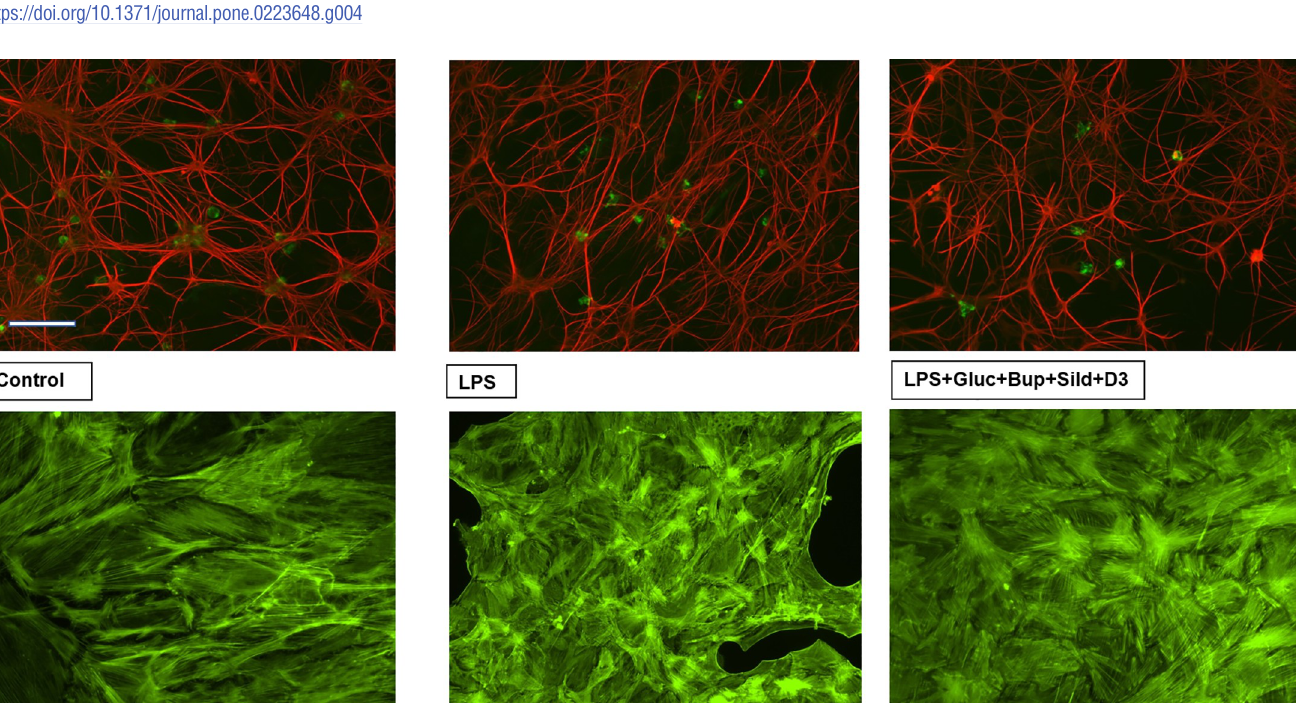
Fig 4. The expression levels of TLR4, NK-1 and Na + /K + -ATPase were studied using western blot analysis. Astrocytes were cultivated in 5.5 mM glucose for the entire cultivation period. The cells were incubated with LPS (10 ng/ml) for 24 h or incubated with LPS for 24 h followed by LPS, 25 mM glucose + bupivacaine (Bup) (10 − 12 M), 25 mM glucose + sildenafil (Sild) (1 μ M) + vitamin D3 (D3) (100 nM), or a combination of all substances for an additional 24 h. The level of significance was calculated against LPS and analyzed using one-way ANOVA followed by Dunnett’s multiple comparisons test. � P < 0.05, �� P < 0.01. n = 6. Representative images of western blot membranes are presented.